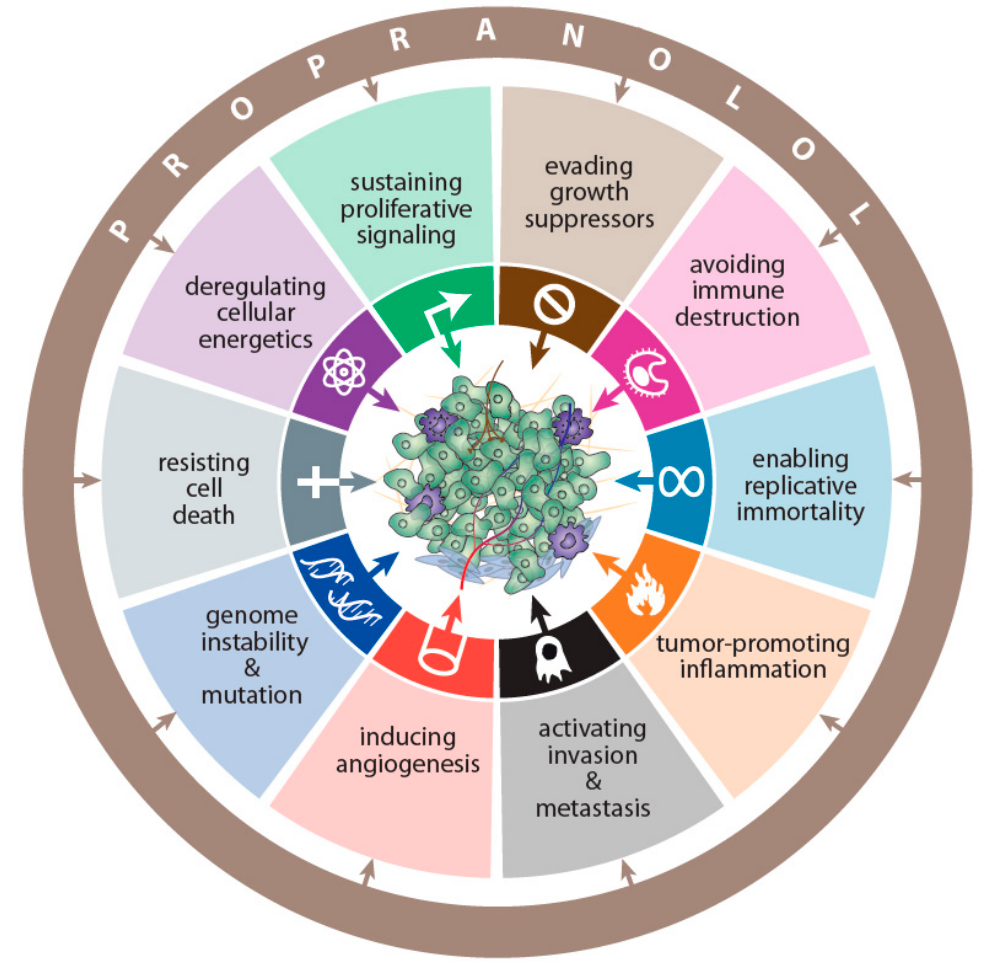
Figure 1. Experimental and clinical studies have shown that propranolol affects all hallmarks of cancer defined by Hanahan and Weinberg [52]. Even if these studies created a basis for potentially employing propranolol in cancer treatment and prevention, further studies are necessary to determine its efficacy in various human cancers.